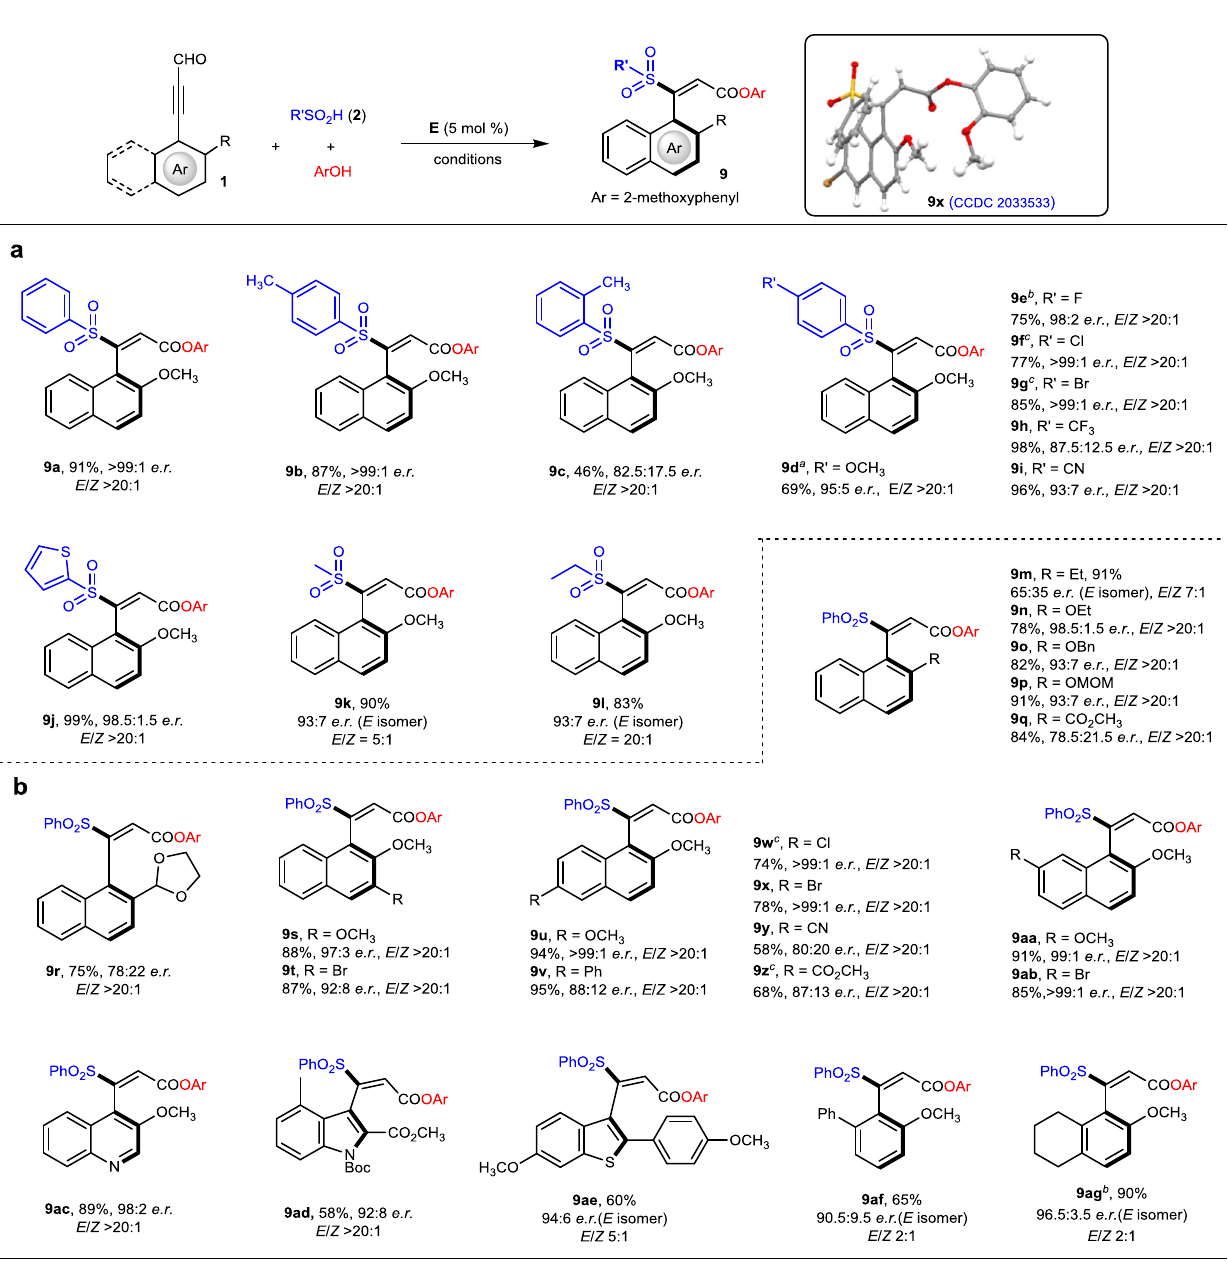
NATURE COMMUNICATIONS| (2022) 13:84